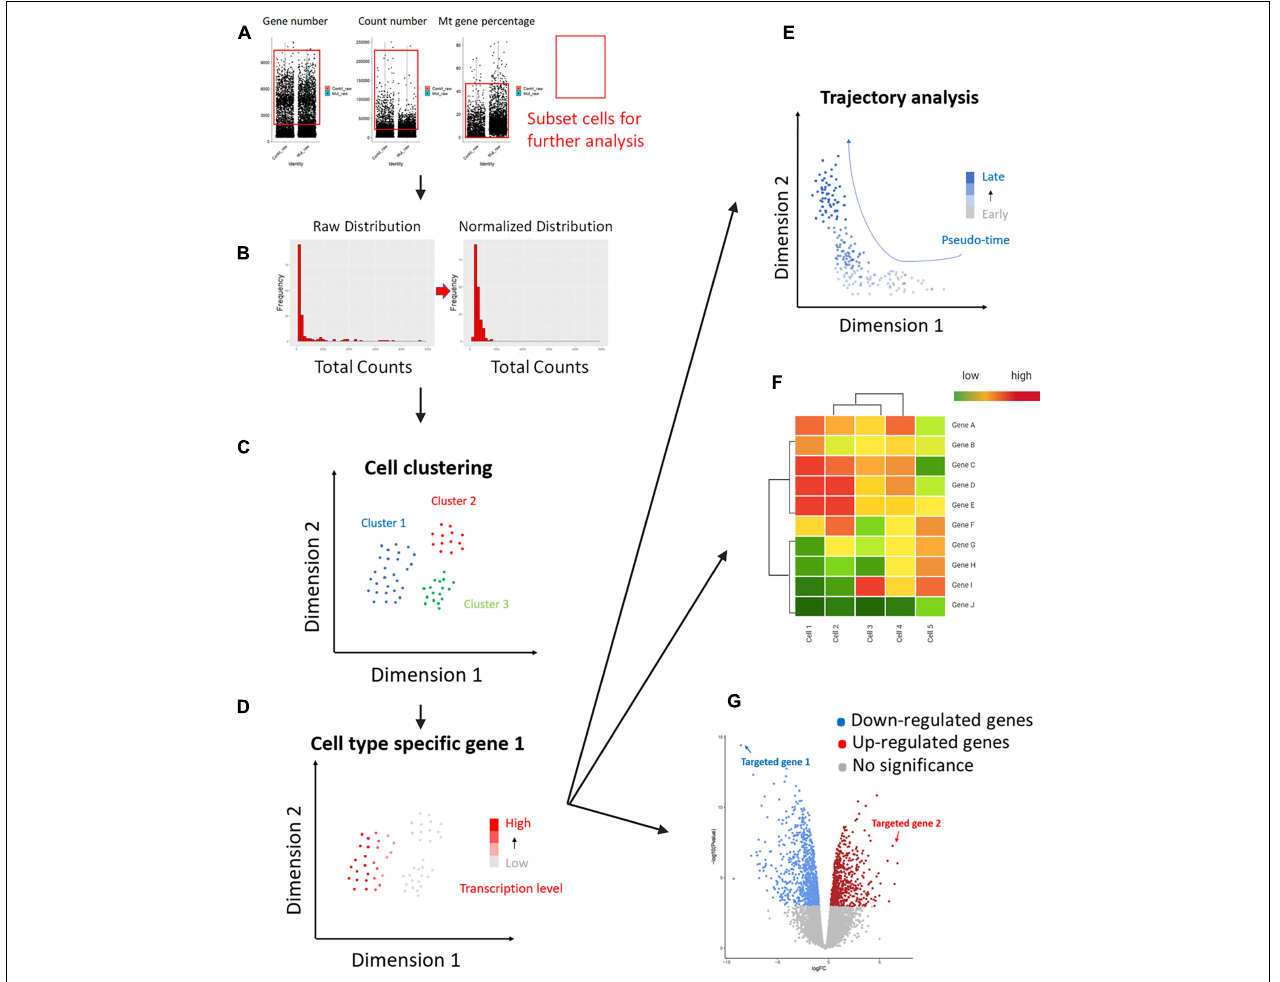
FIGURE 3 | Downstream analysis workflow of commonly used scRNA-seq. Key steps of the scRNA-seq downstream analysis were summarized here (The figure is created with BioRender.com). (A) Quality control evaluated cell quality and filtered qualified cells by captured gene numbers, mRNA total counts, and mitochondrial mRNA percentages. Red rectangles highlighted the cells selected according to the three parameters, respectively. The rest cells were considered as “low quality “cells and not used for the following analysis steps. (B) The normalization method was applied to remove technique deviation, especially different sequencing depth between each individual cell. The mRNA-total-count distribution from the normalized cells (right graph) is closer to normal distribution compared to the raw counts (left graph). (C) Different dimension-reduction methods can be used for cell clustering (see Figure 2 for details). Cells were separated by their transcriptional features. (D) Cell type identification. Separated cell clusters can be identified by using known cell-type-specific markers. (E) Alternative downstream analysis can be applied for different research purposes. Pseudo-time trajectory analysis can be used for tracking cell progression from early to late stages. In meiosis-related studies, trajectory analysis is commonly used for tracking spermatogenesis. (F) Cell-expression data can be used to generate cell clustering heatmaps. Similar cells will be clustered together on the heatmap, and the gene expression data showing their homology and heterogeneity will be shown. In this way, potential gene markers for certain cell types can be easily determined. (G) Differential Gene Expression (DGE) analysis compares differential gene transcription levels between two cell groups or datasets. The identified up- and down-regulated genes provide important information for diagnosis and